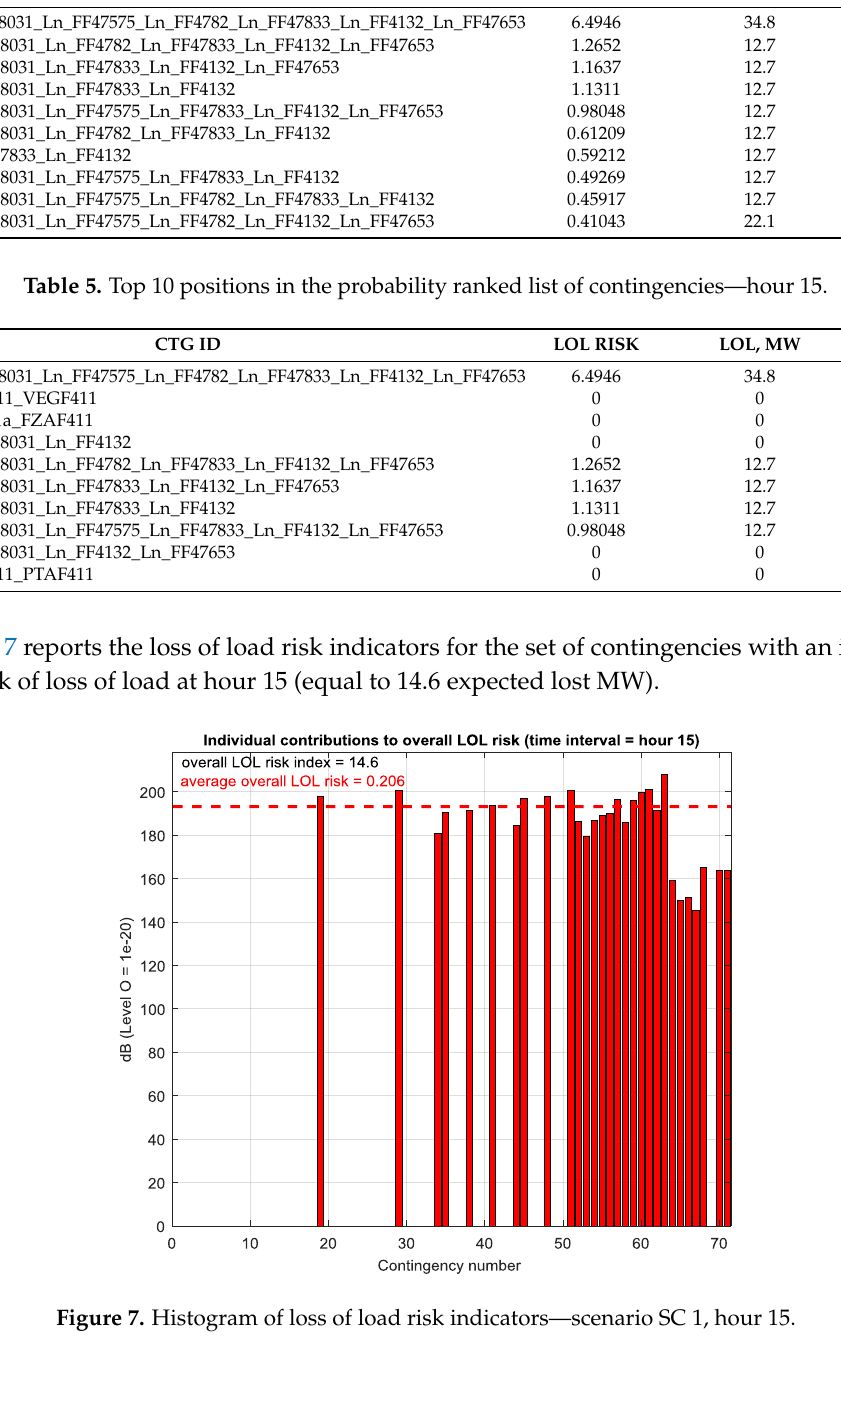
Table 4. Top 10 positions in the risk ranked list of contingencies—hour 15.